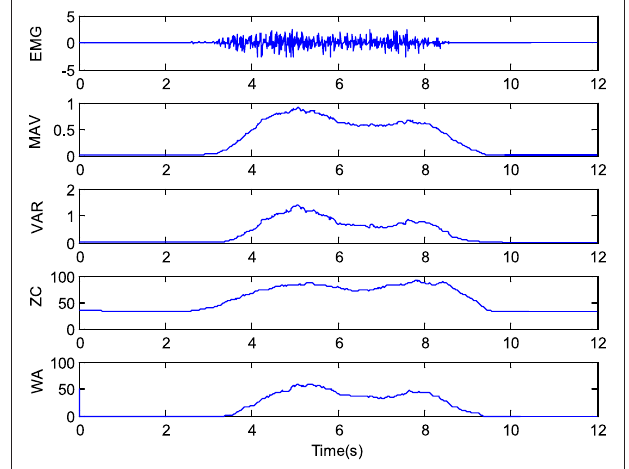
FIGURE 11 | A typical EMG signal and its time domain features.